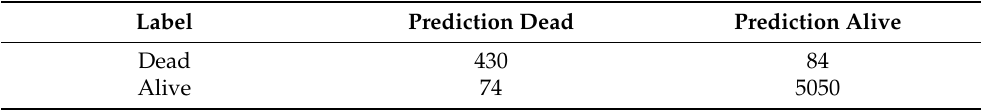
Table 10. Total confusion